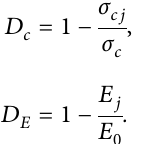
Figure 6: The changes of two damage indices with α